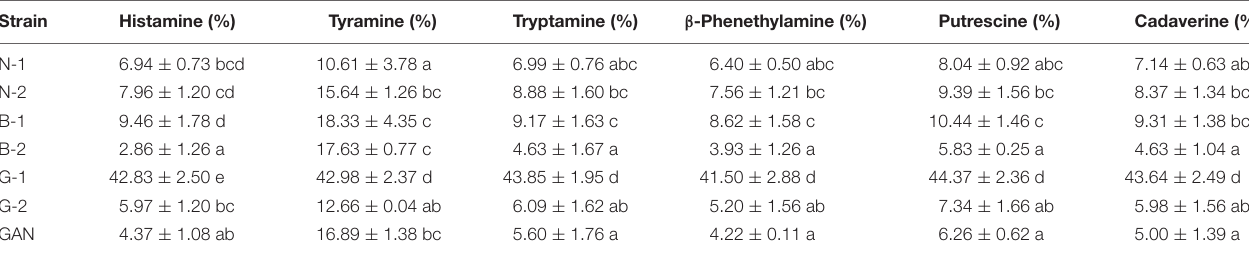
Different letters (a, b, c, etc.) indicate significantly different means at P < 0.05 [analysis of variance